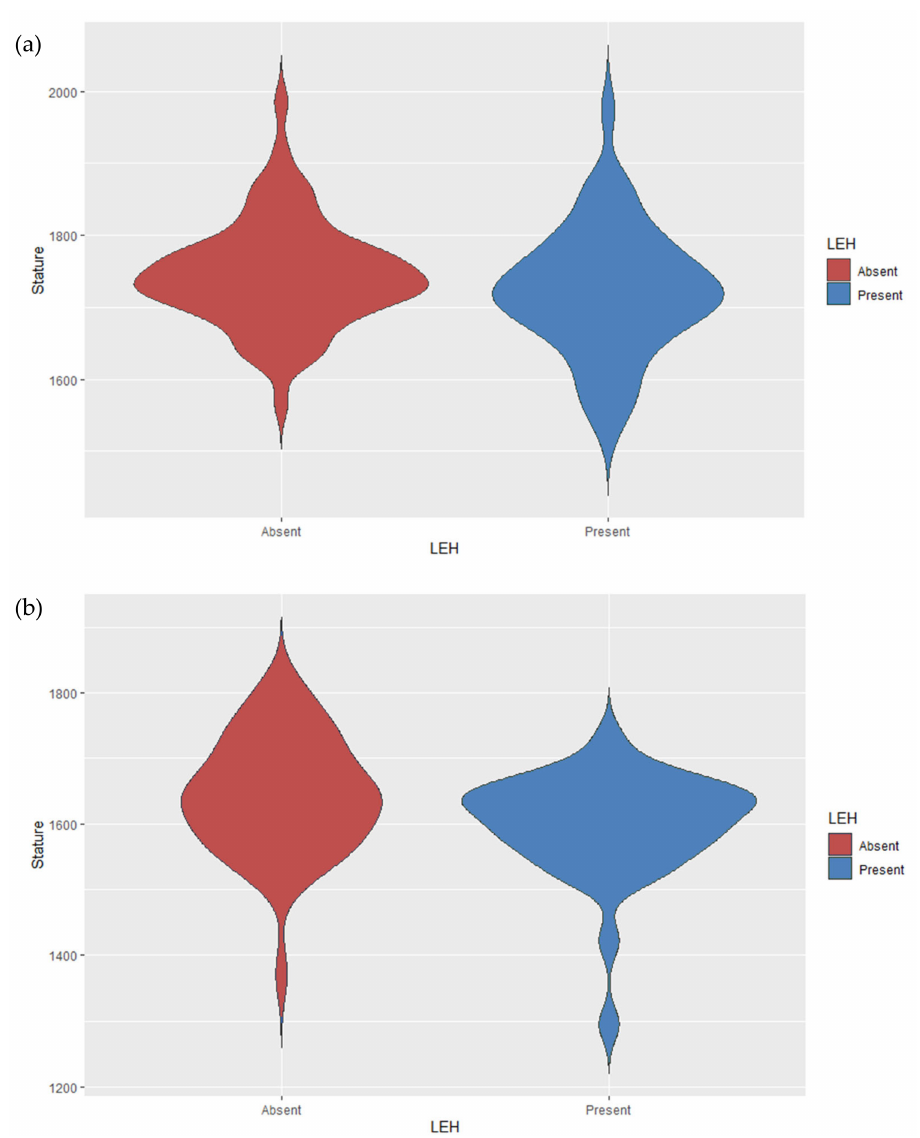
Figure 6. Distribution of statures for individuals without any LEH (absent) and those with at least one LEH (present) for males ( a ) and females ( b ).